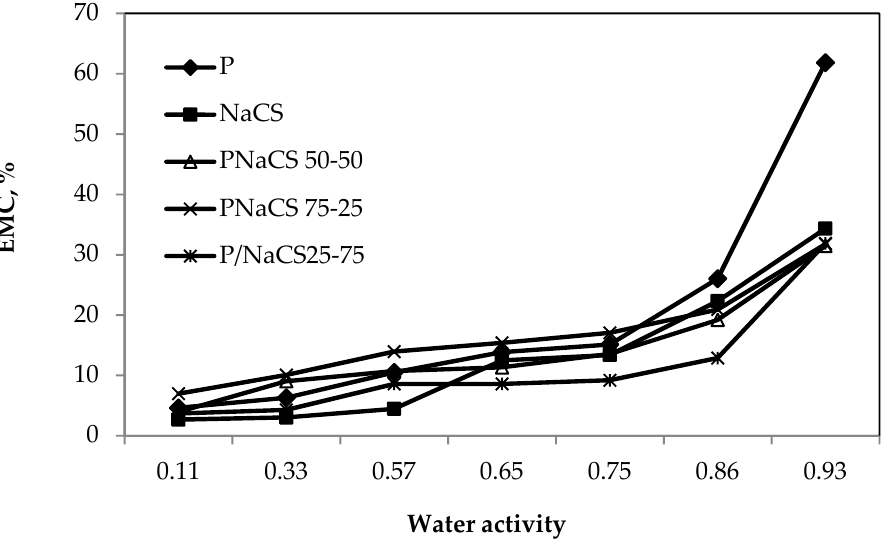
Figure 2. Moisture sorption isotherms of P:NCS films at 25 ± 0.5 °C.